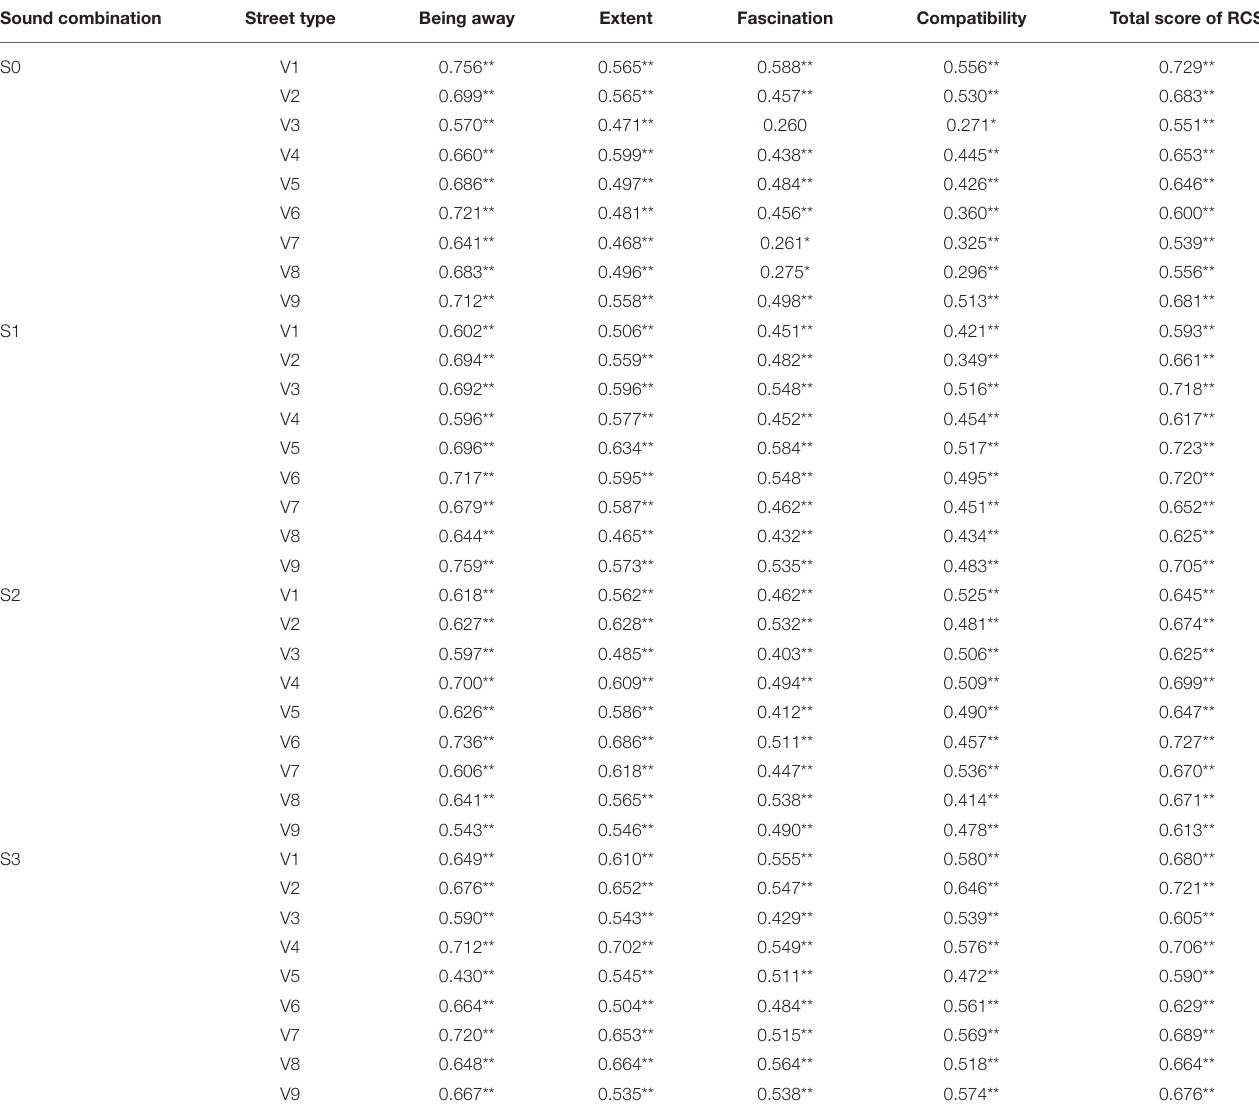
TABLE 4 | Pearson’s correlation results between TR and evaluation of